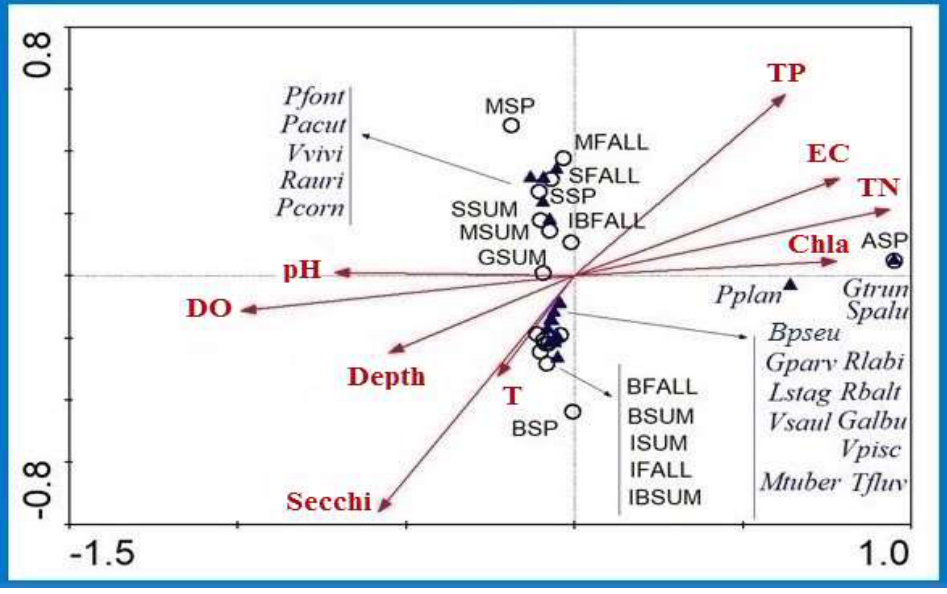
Figure 6. Canonical correspondence analysis triplot with lentic sites (red arrows: environmental parameters, black circles: sites, blue triangle: species; A: Akkaya, IB: İbrala I: İvriz, M: Mamasın, S: